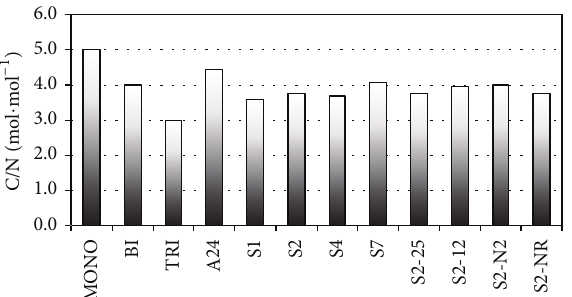
Figure 3: Ratio of C/N elemental composition of aminopropyl- functionalized